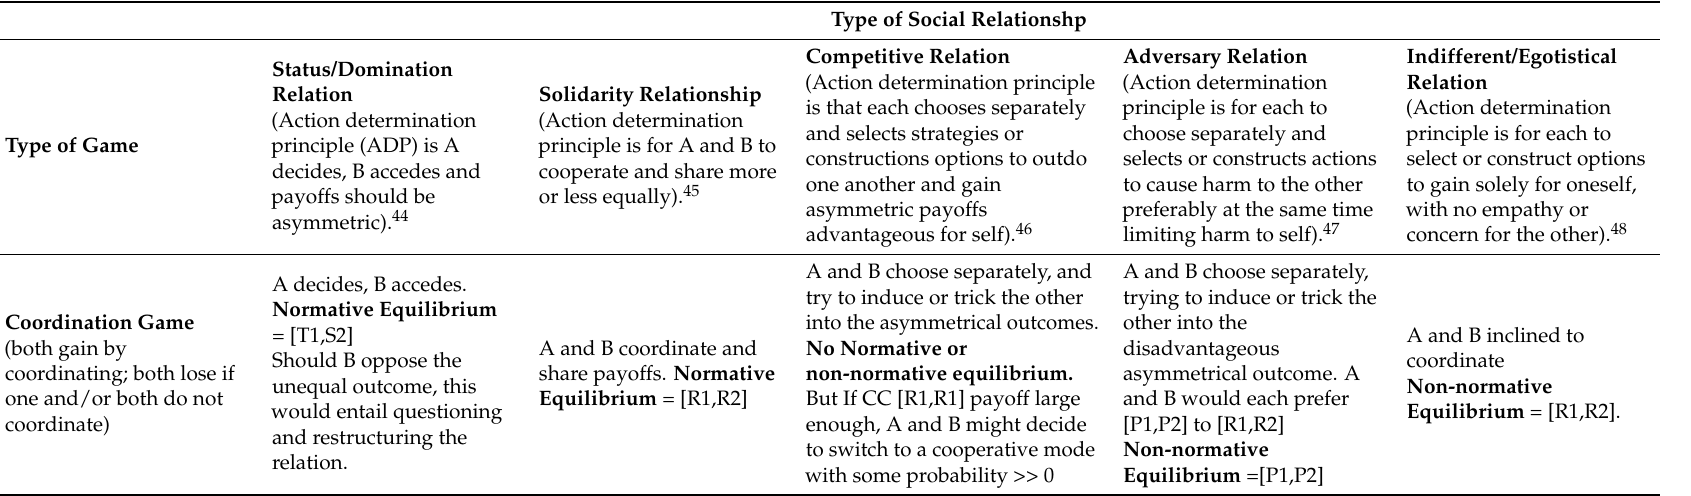
Table A3. Social relationships with particular roles, types of game situation, interaction patterns and social/normative